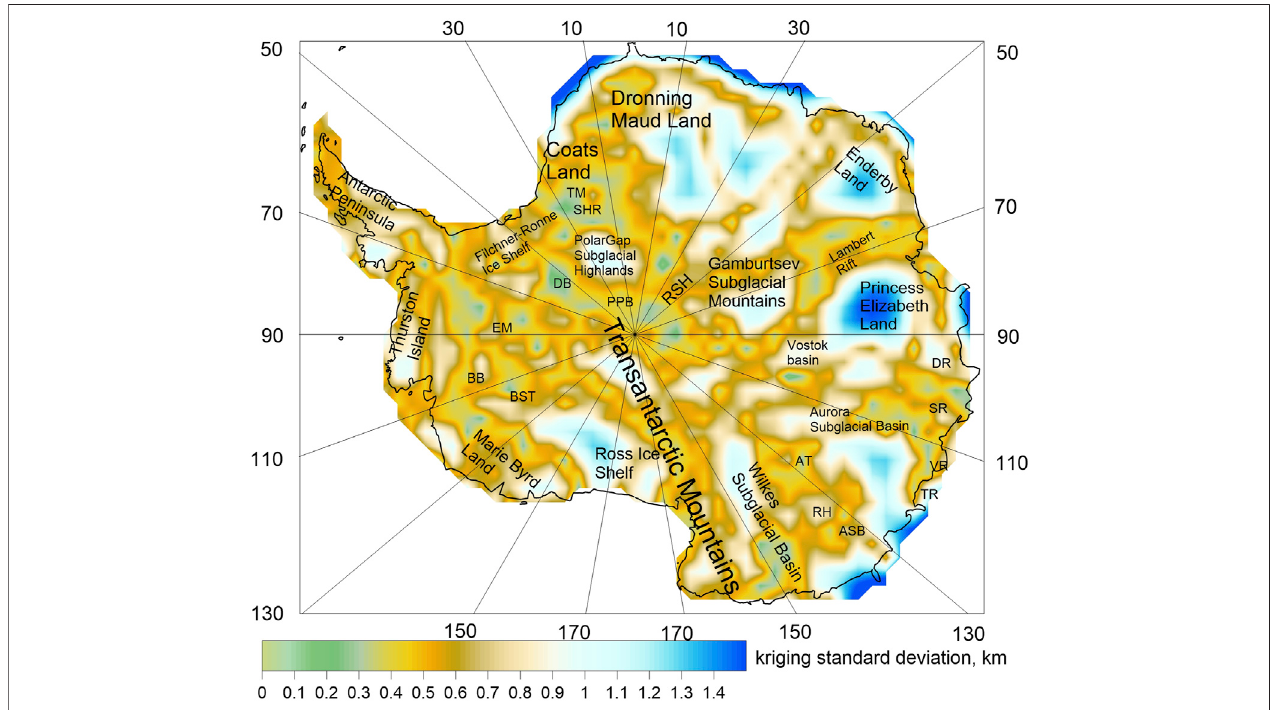
FIGURE 2 | Map of kriging standard deviation. It is used the same abbreviations as in Figure 1 .